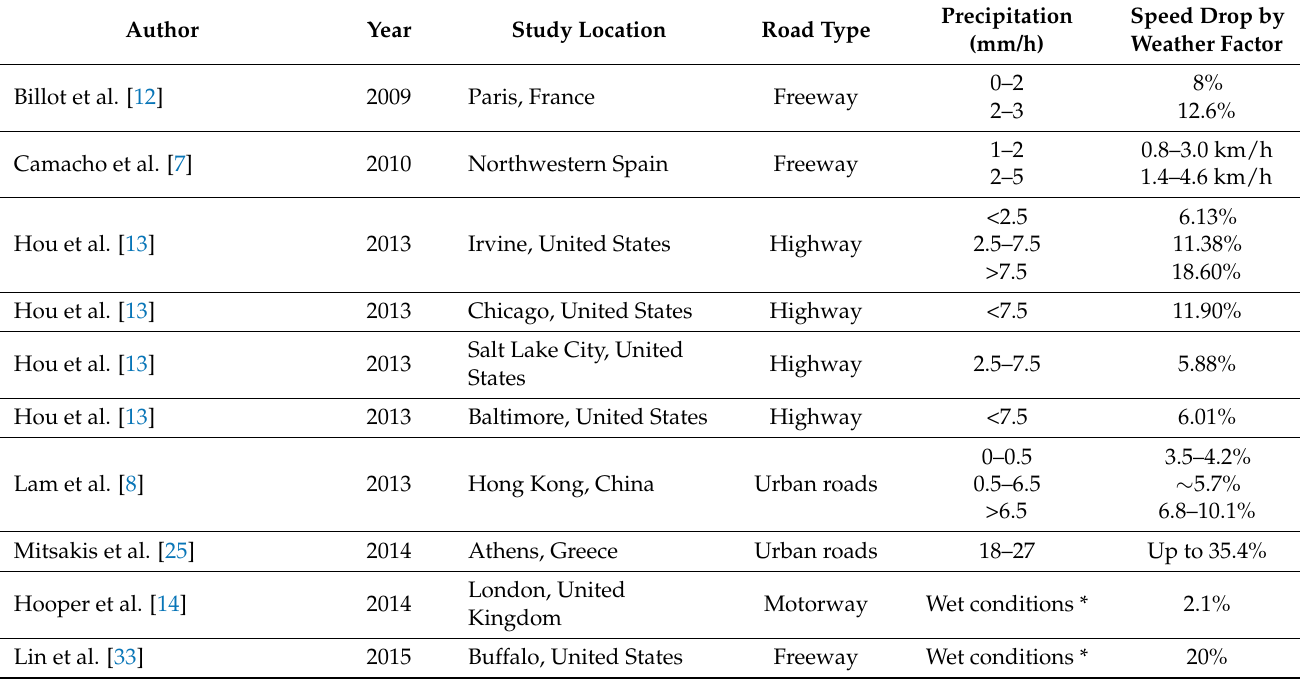
Table 1. Recent studies on the effect of rainy weather on vehicle speed